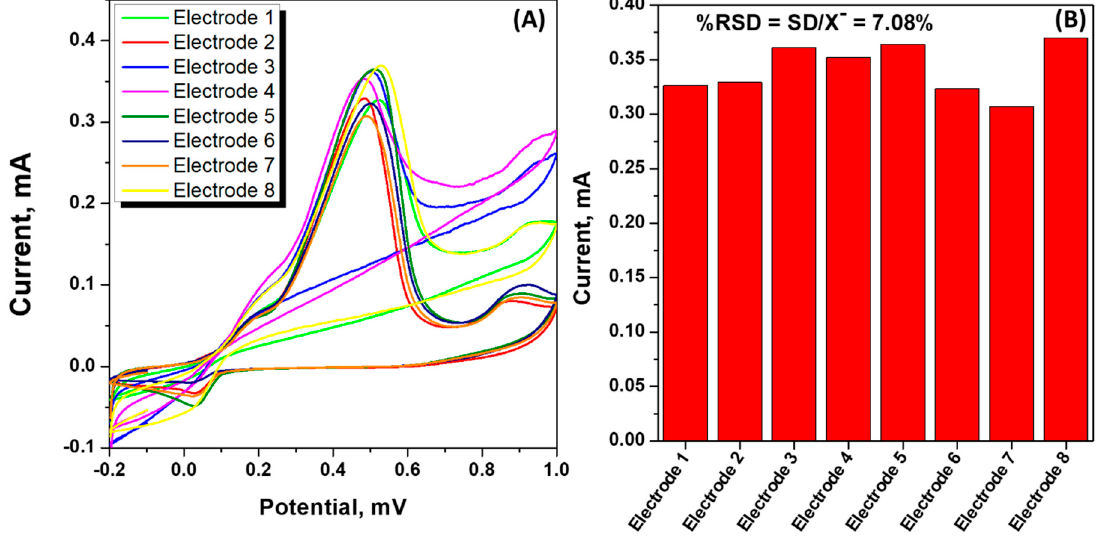
Figure 7. ( A ) Cyclic voltammograms and ( B ) histogram representation of the current responses of eight different SPCE/CuS-2 in 0.01 M phosphate buffer solution containing 3 mM glucose. eight different SPCE/CuS-2 in 0.01 M phosphate buffer solution containing 3 mM